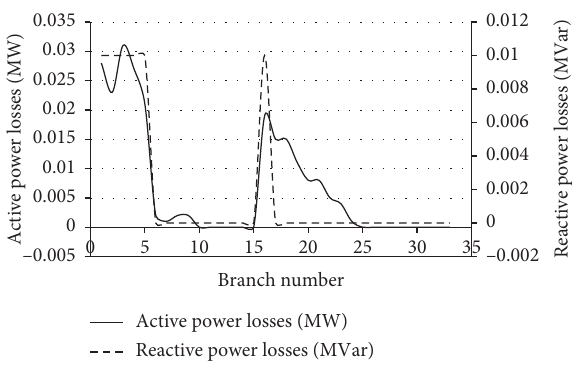
Figure 5: Active and reactive power losses after a DG